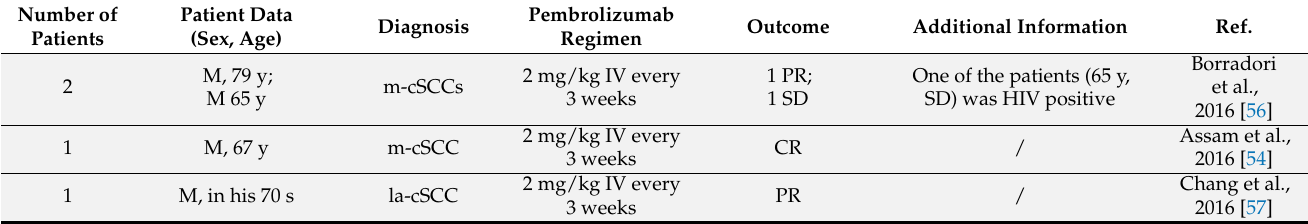
Table 3. Reported cases of locally advanced and metastatic non-melanoma skin cancers treated with